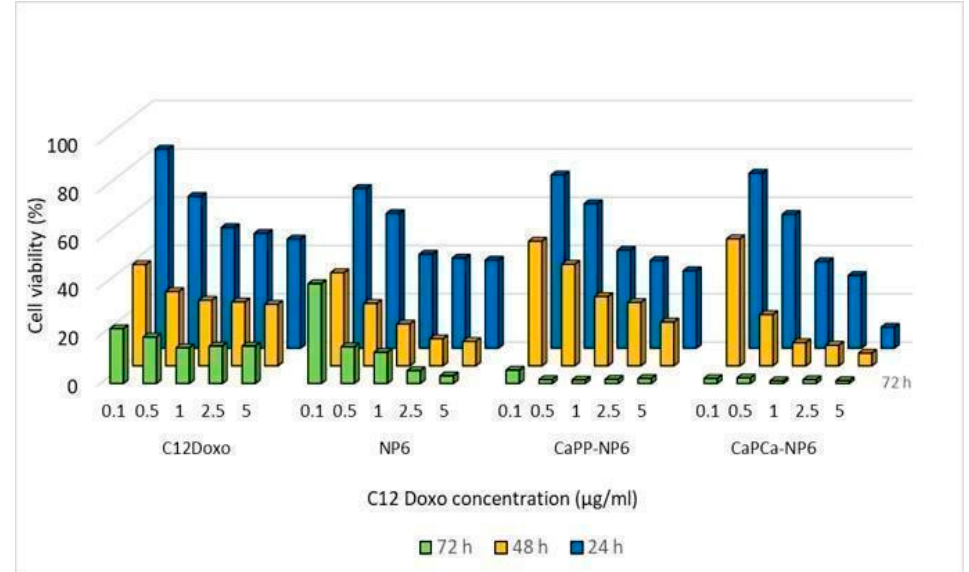
Figure 7. D17 cells were incubated with NP6, CaP P -NP6, and CaP Ca -NP6, carrying 0.1, 0.5, 1, 2.5, or 5 µg/mL C12DOXO, for 24, 48, and 72 h. Cell viability was measured using the MTT assay. Results are means + SD ( n = 3).